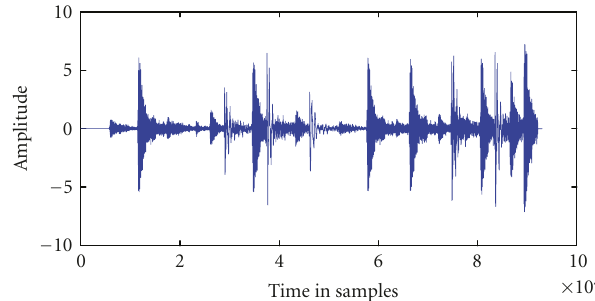
Figure 14: A realistic music signal played by a guitar.